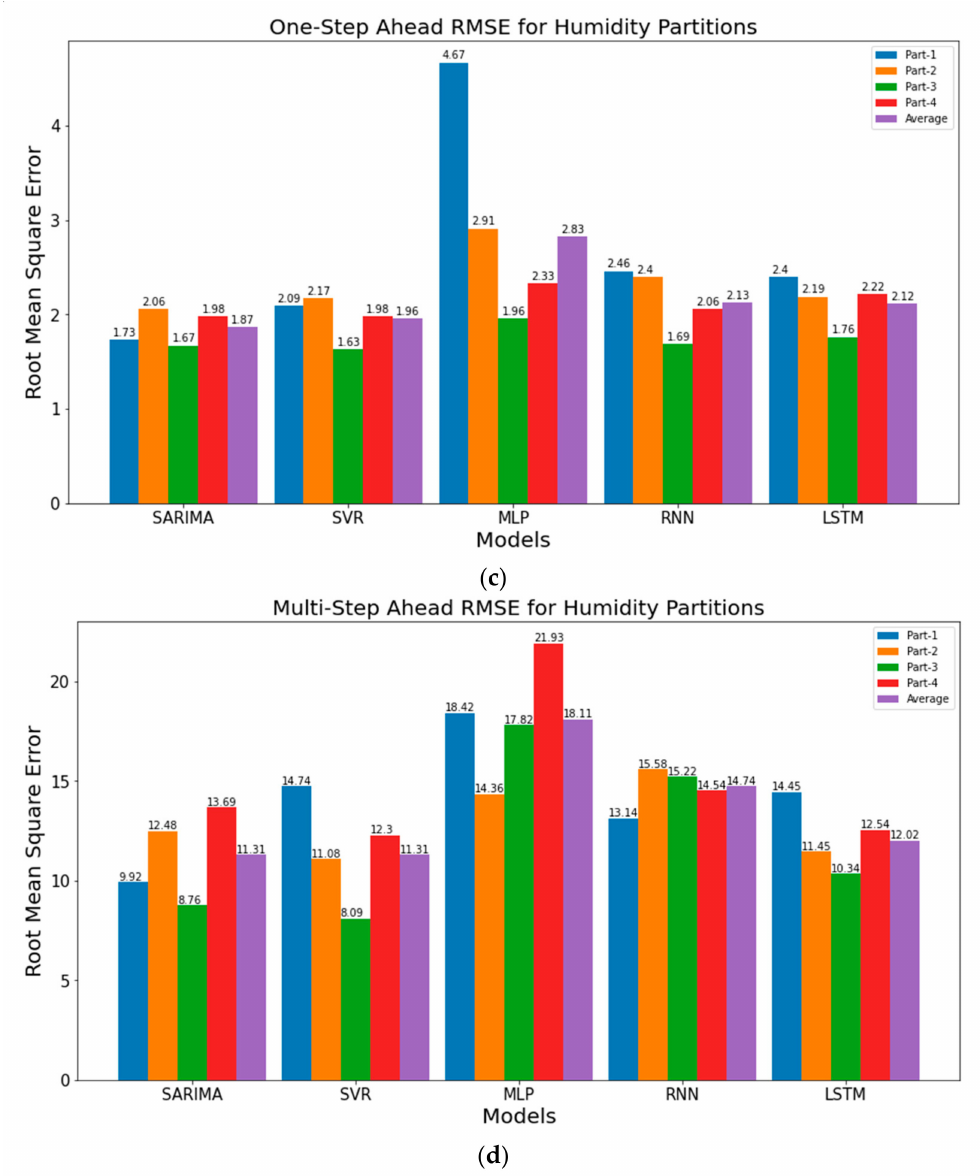
Figure 11. Comparison of forecast performance of TSFA over fixed data partitions (7-day) and average performance with walk-forward validation ( a ) One-step ahead Temperature ( b ) Multi-step ahead Temperature ( c ) One-step ahead Humidity ( d ) Multi-step ahead Humidity ( top to bottom